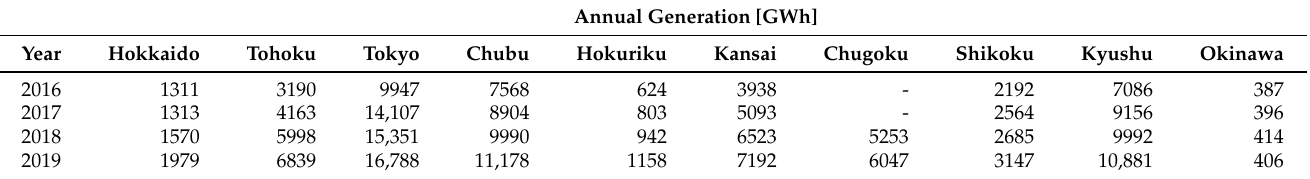
Table A2. Annual Generation by region between 2016 and 2019 [GWh].